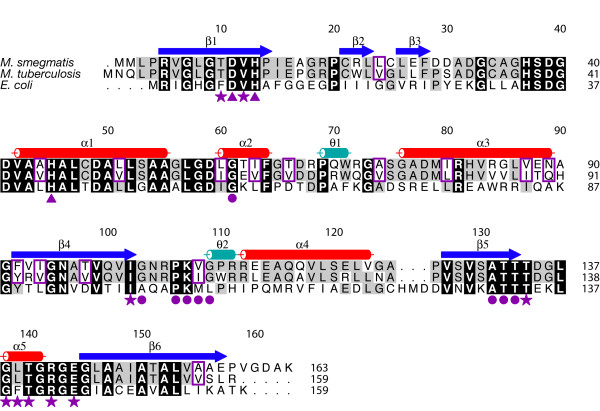
IspF homology. Amino acid sequence alignment of MsIspF, MtIspF, and EcIspF. Secondary structure elements of MsIspF are shown above the sequence. β-strands are blue, α-helices red, and 310-helical segments aquamarine. MsIspF and EcIspF are aligned based on a structural overlay. Residues boxed in black are strictly conserved and those in grey are identical in two of the three sequences; similar residues from the Mycobacteria sequences are outlined in a purple box. ▲ identifies residues that interact with Zn2+, τ with Mg2+, H with CDP, and ♥ with the 2C-methyl-D-erythritol moiety of substrate; λ denotes residues that line the hydrophobic cavity. The residues that bind Mg2+ and the ME2P fragment of substrate are based on observations in EcIspF.